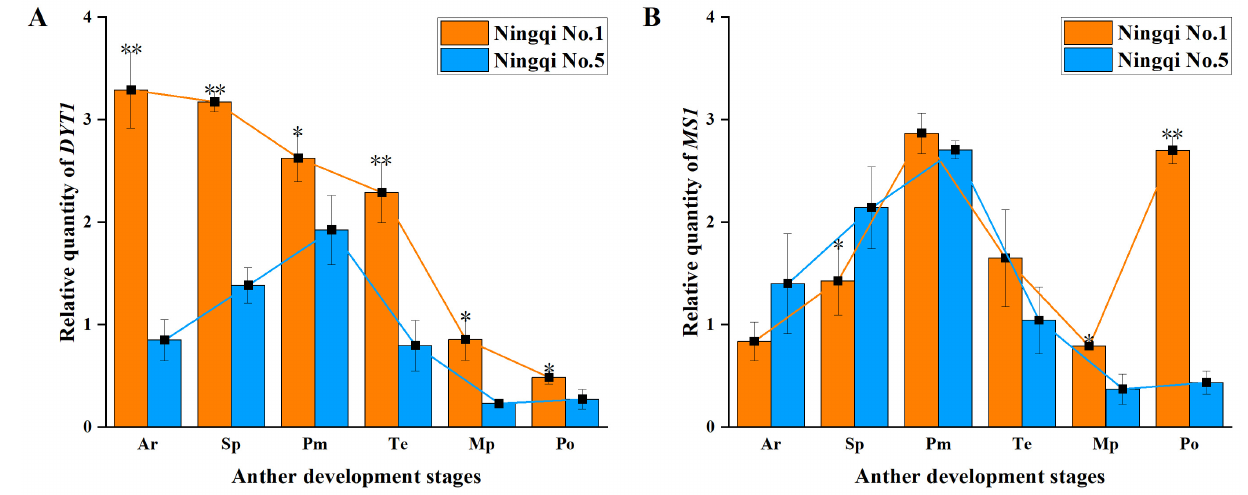
Figure 7. Relative quantity of DYT1 gene ( A ) and MS1 gene ( B ) during anther development in Ningqi No. 5 and Ningqi No. 1. ( A ) Relative quantity of DYT1 ; ( B ) relative quantity of MS1 . Ar, archesporial cell stage; Sp, sporogenous cell stage; Pm, pollen mother cell stage; Te, tetrad stage; Mp, mononuclear pollen grain stage; Po, pollen grain stage. *, ** represents p < 0.05 and p < 0.01,